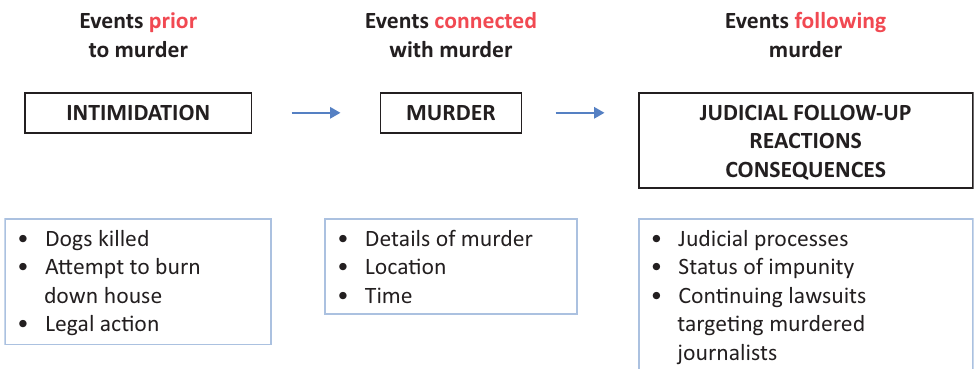
Figure 2. Event-based representation of the case of Daphne Caruana Galizia, with an ‘intimidation’ event containing sepa- rate sub-events of ‘dog killing’ and ‘home burning attempts,’ followed chronologically (though not necessarily causally) by the ‘murder’ event (the car bomb), and subsequently by various judicial follow-up events. Note: Each of these events has a number of features attached to it (not depicted), such as the name of the victim, a date, and